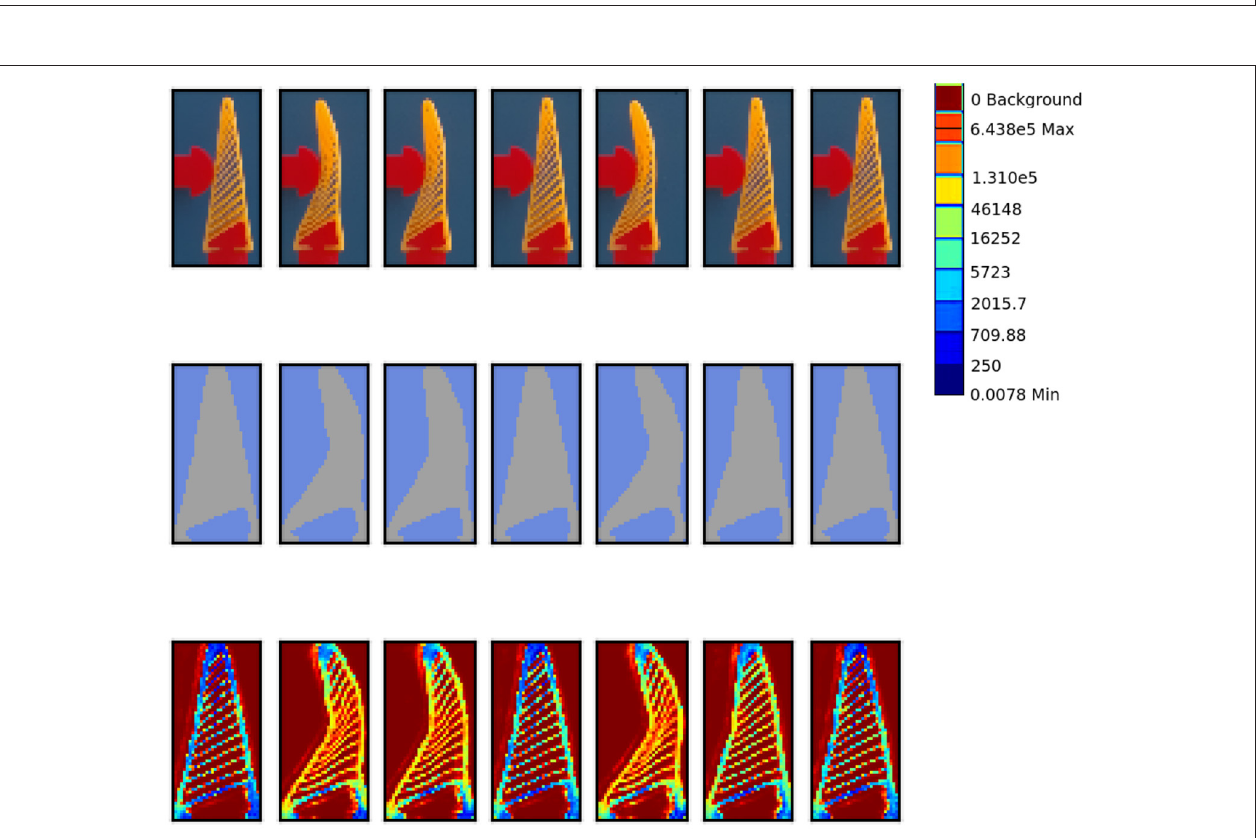
FIGURE 12 | Stress estimation for real objects. We showcase the stress maps predicted by our network for real objects without retraining. (Top) Cropped image as input, (Middle) Deformation image obtained after the image pre-processing module, this is fed to the network (Bottom) The stress map predicted by our network. Note that the true stress map could not be obtained for the real data using FEA thus we only present the predictions by our